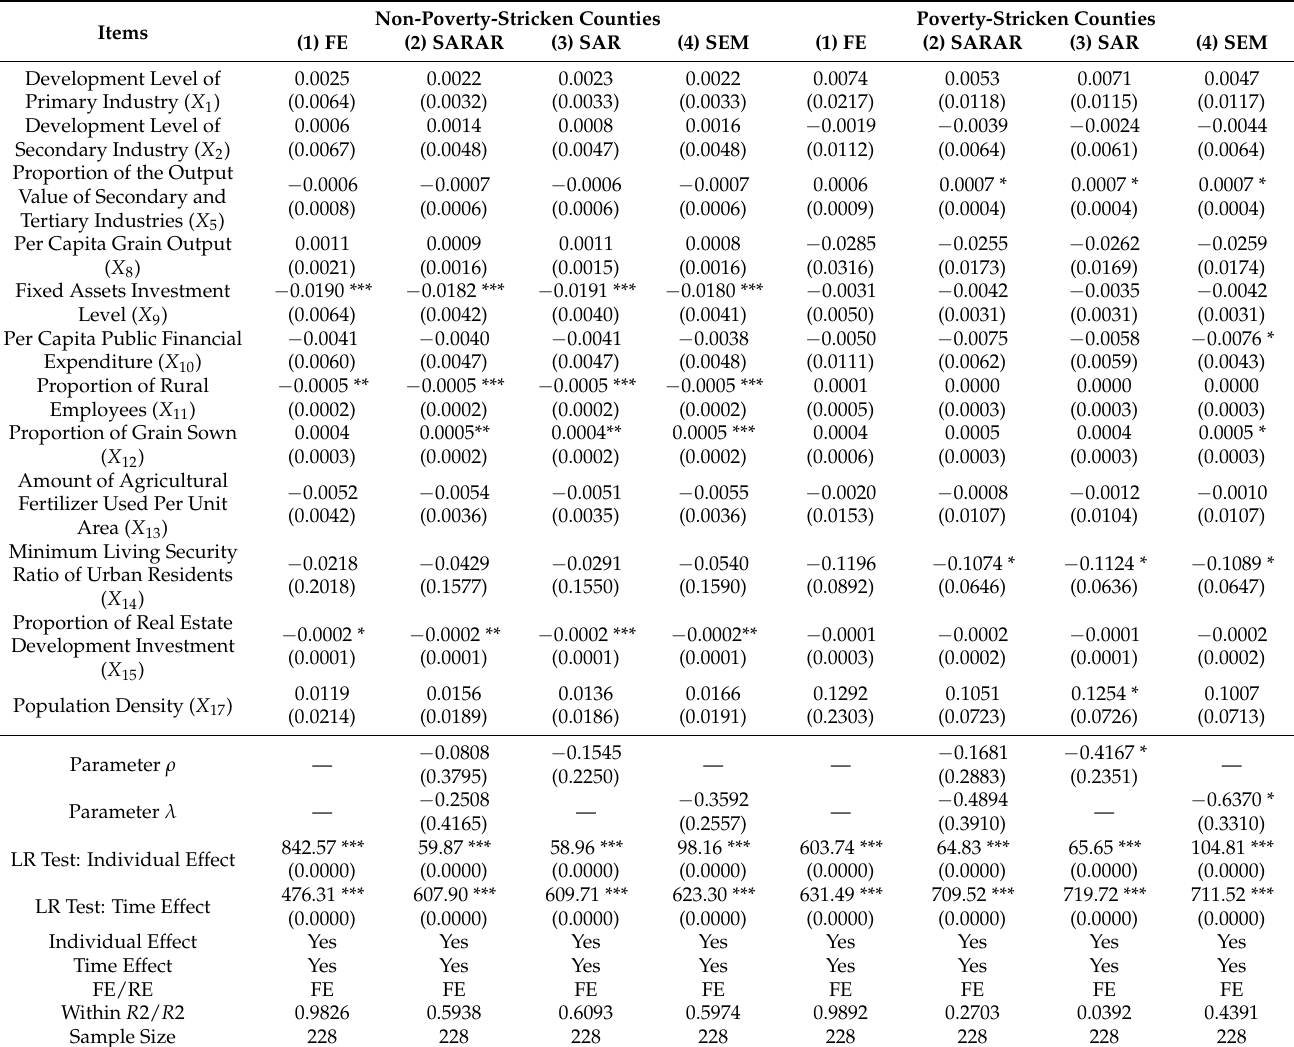
Table 3. Estimation results of the econometric model for the analysis of factors influencing the urban–rural income gap in non-poverty-stricken counties and poverty-stricken